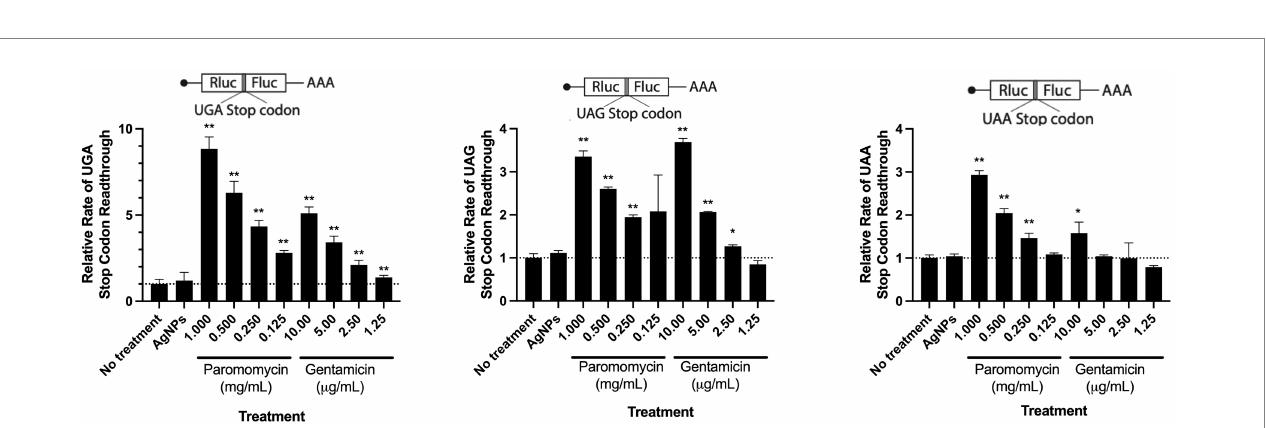
FIGURE 5 The effect of AgNPs on translation fidelity. Bar graphs representing relative rates of readthrough three stop codons: UGA (left), UAG (middle), and UAA (right). Dose–response concentrations of aminoglycosides paromomycin and gentamicin were used as positive controls. Each bar is an average of a minimum of three biological replicates. Error bars represent standard deviation (StDev). Statistical significance was calculated using the Student t-test (* p < 0.05, ** p <